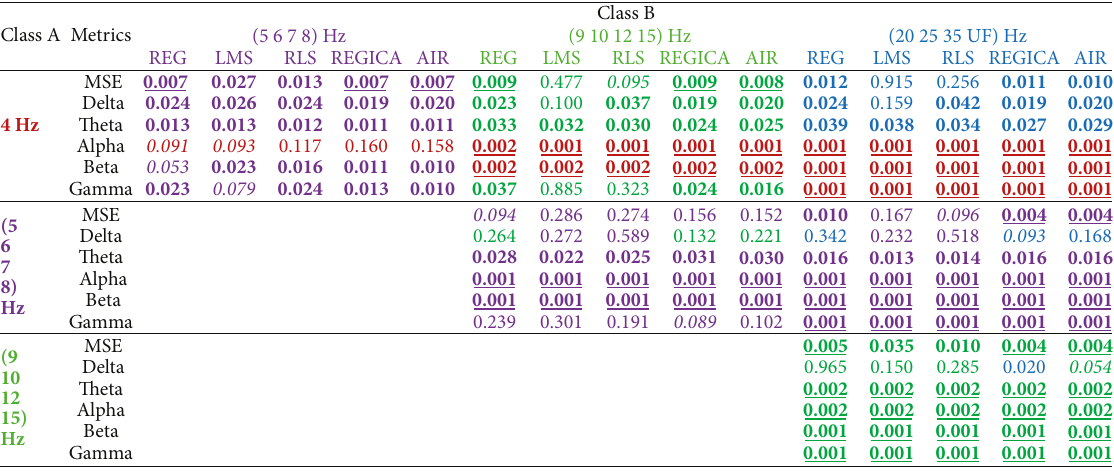
Figure 5: Statistical increases between di ff erent metrics for artifact corrections with di ff erent EOG fi ltering (paired t -tests were used between class A versus class B). Bold and underline: p < 0 01 ; Bold: p < 0 05 ; Italic: p < 0 1 ; Color indicate better